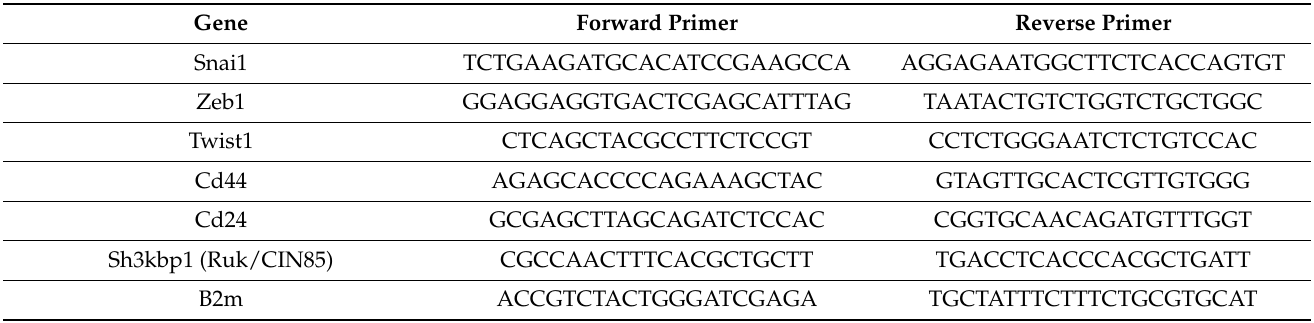
Table 1. Primers sequences, used for real-time